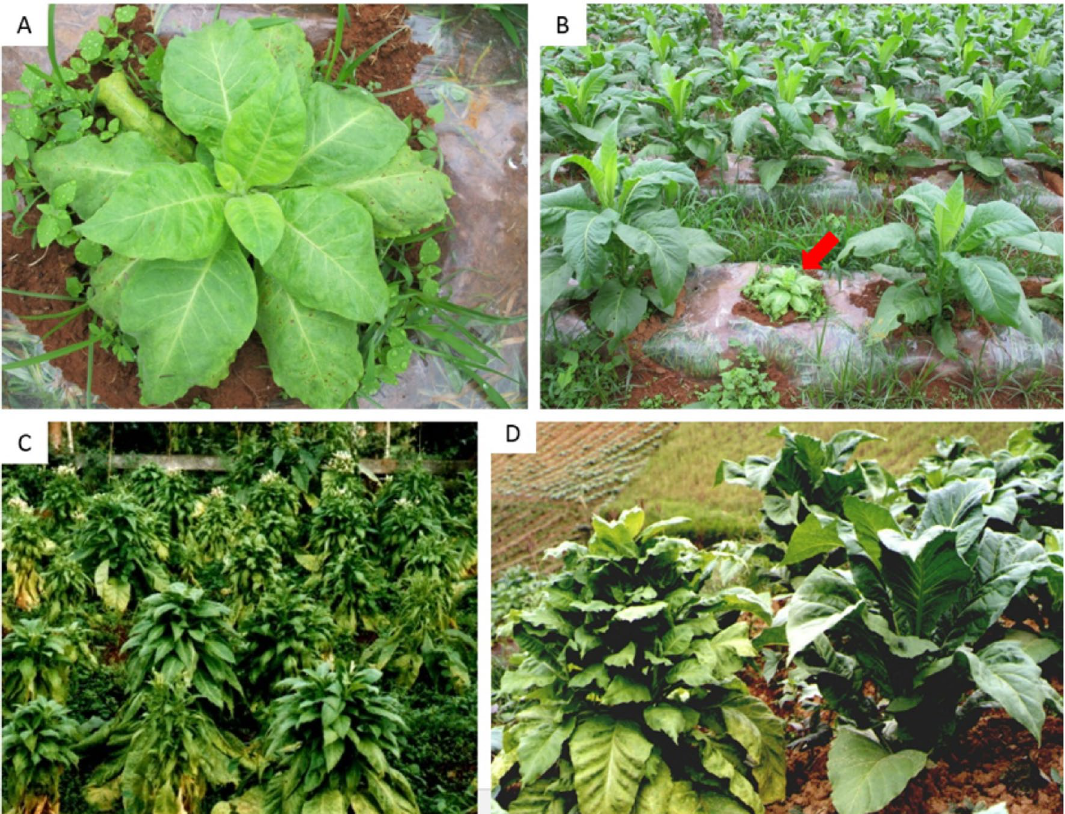
Figure 1. Symptoms of TBTD-affected flue-cured tobacco cultivar K326 in field. Symptoms of an early infection on tobacco plant including chlorosis, internode shortening and serious stunting ( A ). Early infected plant (indicated by the red arrow) and healthy looking tobacco plants ( B ). Late infection symptoms on tobacco plants showing lateral branches proliferation, small leaves, foliar yellowing or chlorosis, stunting ( C ). Late infected plant (left) and healthy looking tobacco plant (right) ( D